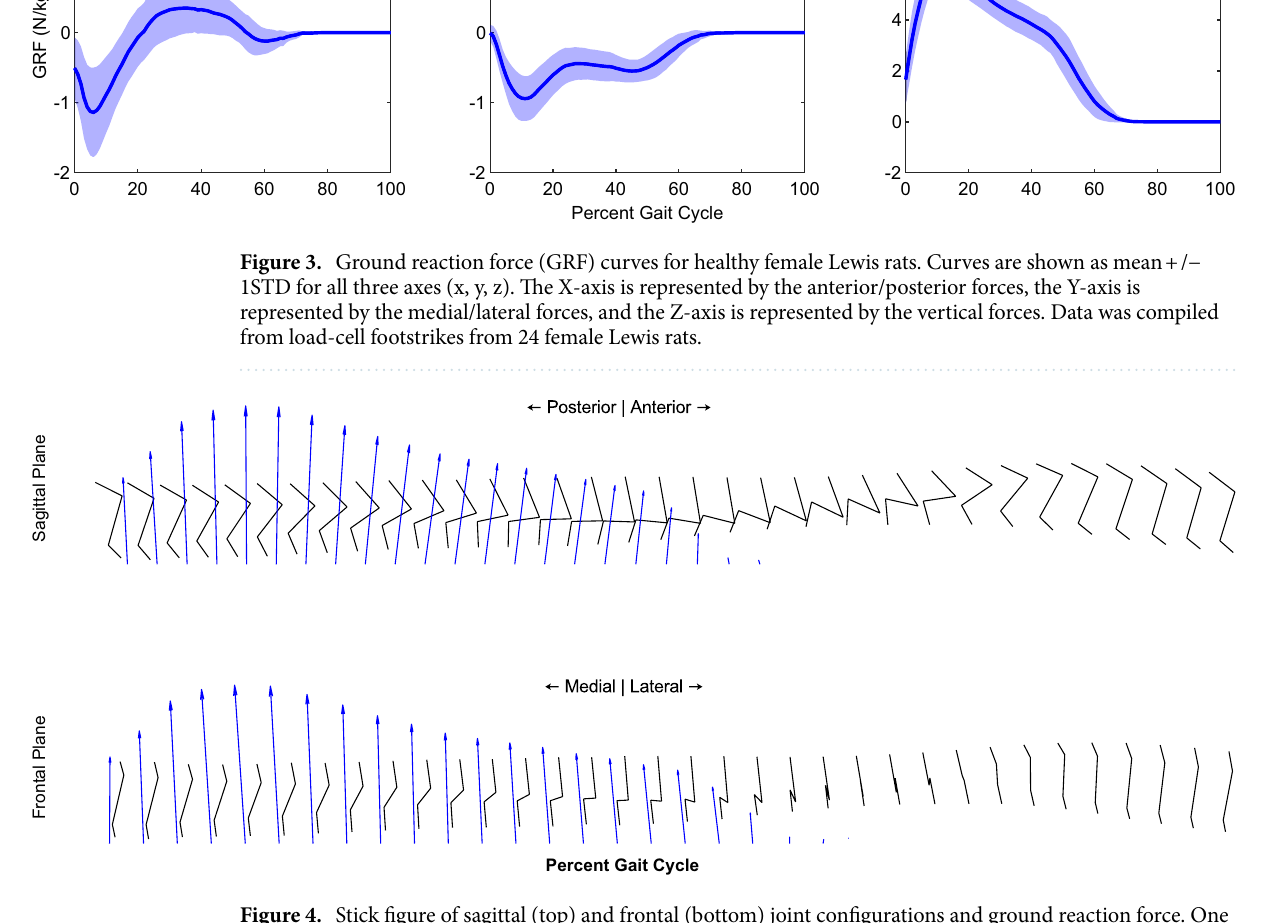
Figure 4. Stick figure of sagittal (top) and frontal (bottom) joint configurations and ground reaction force. One typical stride shown, initial heel strike (left) to final heel strike